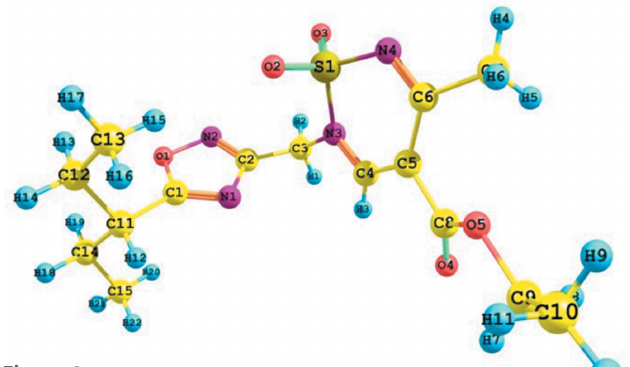
Figure 8 Calculated structure of the title